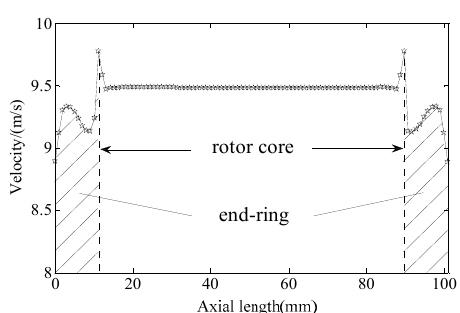
Figure 14. Fluid velocity distribution on rotor surface along axial.